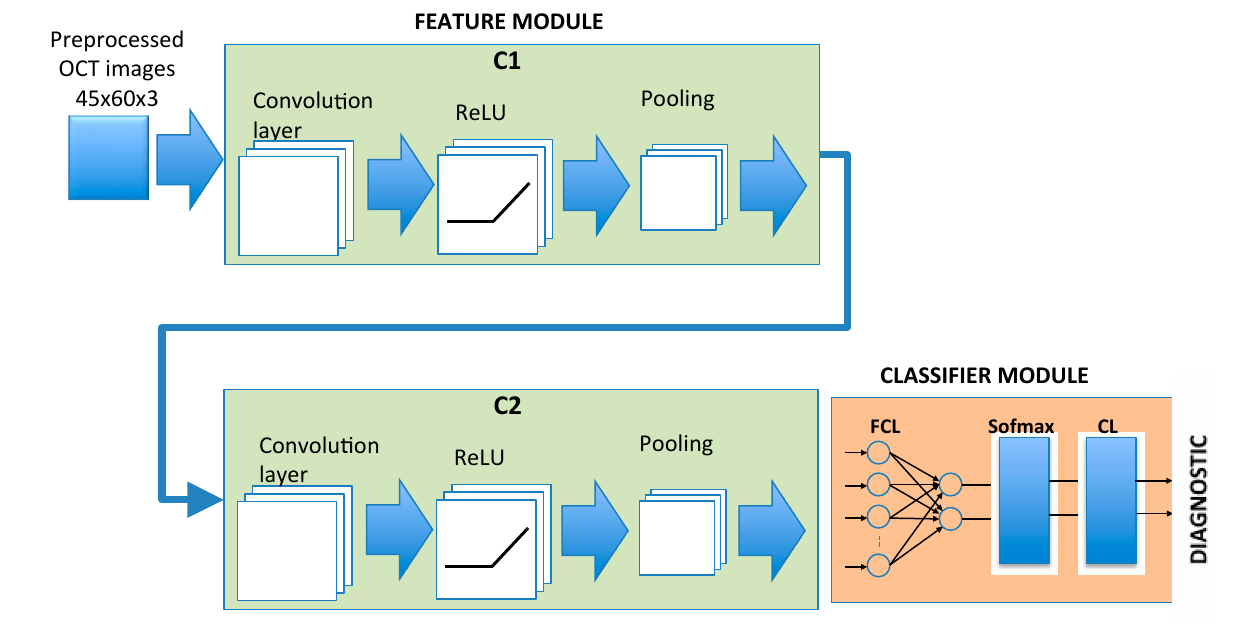
Figure 3. CNN architecture implemented. C1 , C2 : convolutional submodules. FCL: fully connected layer. CL: classification layer.